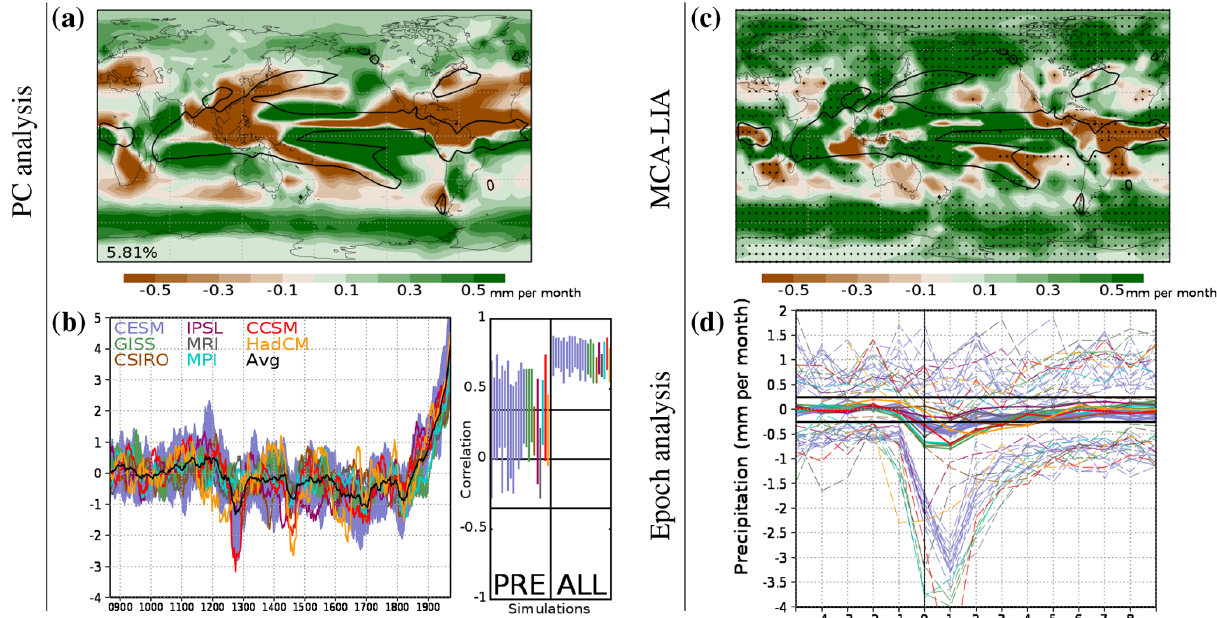
Figure 11. Analysis of precipitation for the ensemble of simulations included in Table 1. (a) Second EOF and (b) second PC time series for each simulation, as well as the average PC of all the simulations (black line). The percentage of explained variance is shown within the EOF map. The range of correlations between the PC of each simulation and those of other simulations is also included on the right of the plotted PCs both for the whole period (ALL) and for the preindustrial era (PRE). For these correlations, the significance level ( p < 0 . 05) accounting for autocorrelation is shown with a black line. (c) Map of precipitation differences between MCA and LIA. Dots indicate locations where the differences are significant ( p < 0 . 05). Contours with climatological precipitation of 120mm per month are included in black in the EOF and MCA–LIA maps. (d) Composite average (solid lines) and maximum and minimum (dashed lines) global precipitation anomalies in the 5 years before and 10 years after the 12 main volcanic eruptions of the LM. The vertical line indicates the year of the volcanic event. The horizontal black lines show the significance level of the average ( p < 0 . 10) based on the distribution of averages of 12 years generated with 2200 sets randomly taken from the whole period excluding the years of the 12 main volcanic eruptions and the 10 years after